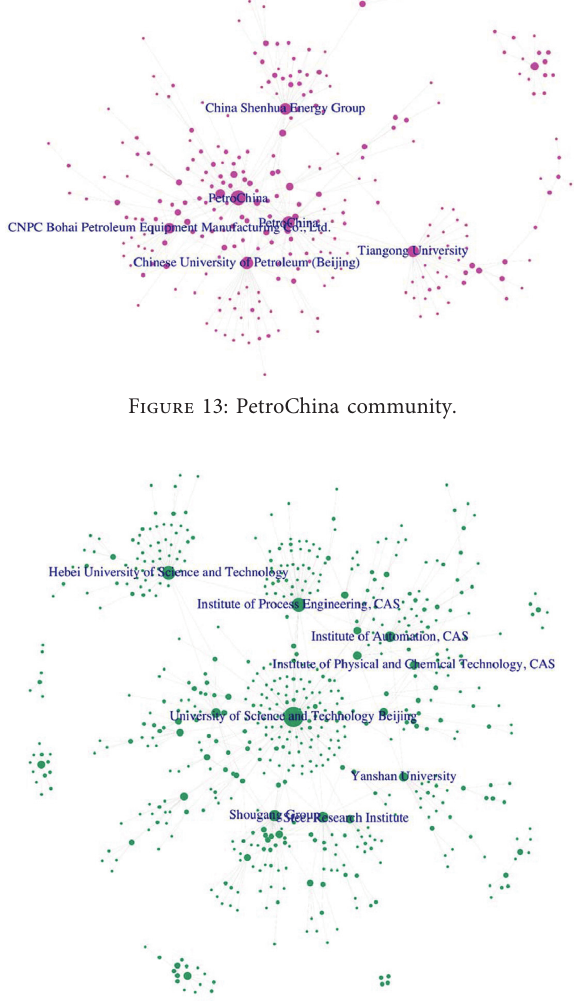
Figure 14: Community #4 in the field of metallurgy and